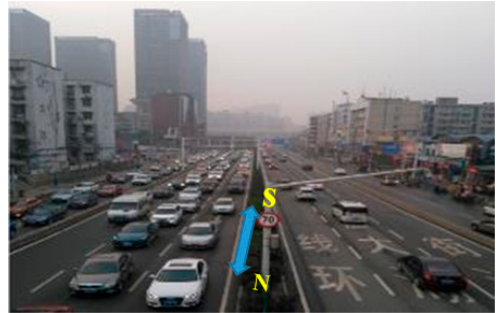
Figure 1. Tidal phenomenon of urban road traffic (Photo was taken on Wednesday, 9 November 2016 at 7:23 a.m.).